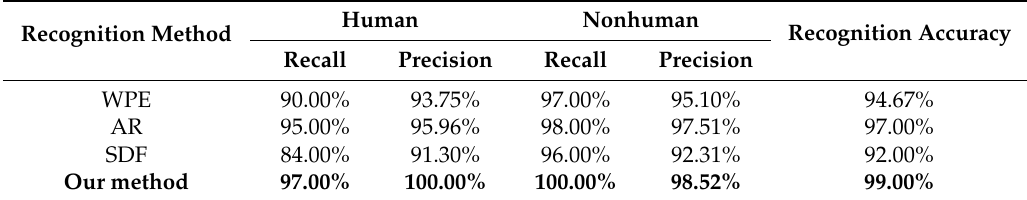
Table 9. Recall, precision and the overall recognition accuracy of each method in the comparative experiments on Database